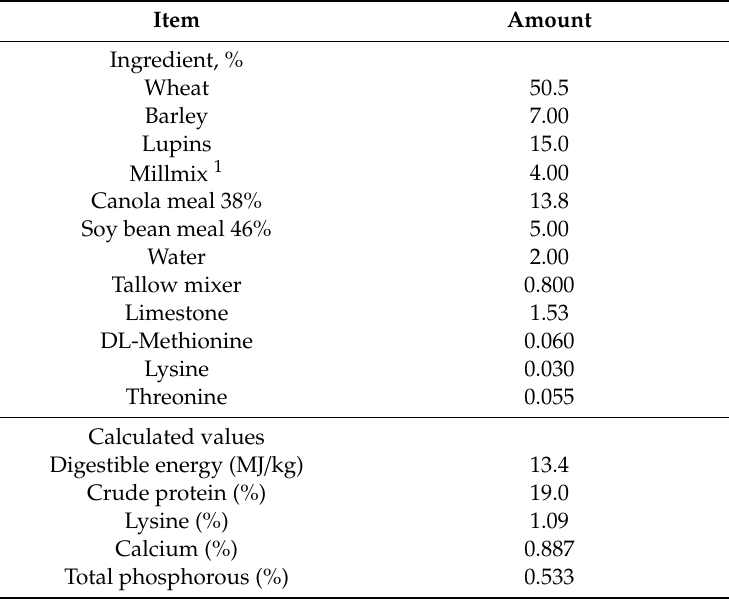
Table 1. Ingredient and composition of diets as fresh feed